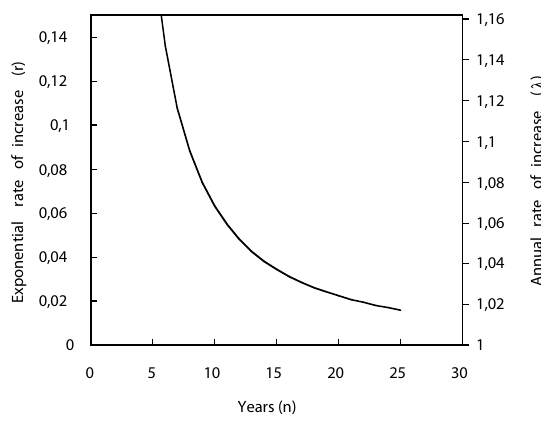
Fig. 5. The time to detect a 0.05 decline in the population growth rate depends on the mean popula - tion growth rate. It would take 25 years to detect a 5% change if the mean rate of increase was 0.02. At the observed rate of increase of the Baltic grey seals (Fig. 2) it will take about 9 years to detect a change in trends from 0.075 to